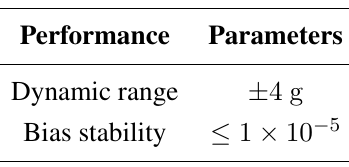
Table 9. The main parameters of the accelerometer.